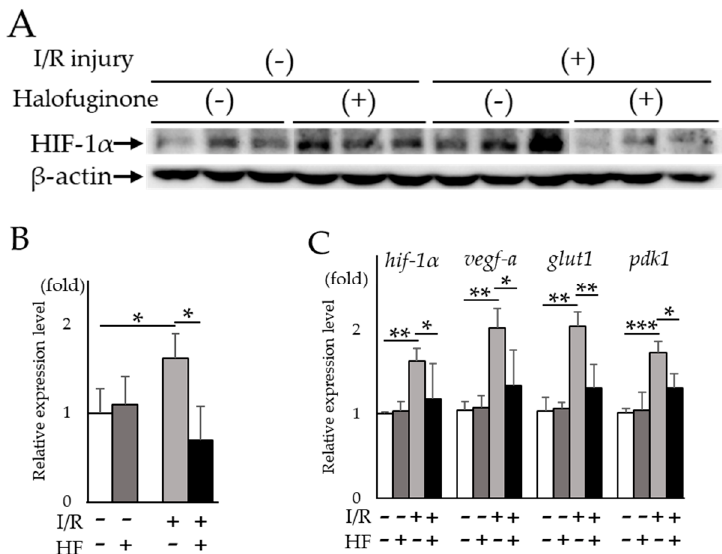
Figure 3. Suppression of increased HIF-1 α and upregulated target genes by halofuginone administration in I / R retinas. ( A ) Western blotting for HIF-1 α and β -actin in control or I / R retinas with or without halofuginone administration ( n = 3). ( B ) Quantification of the blots showed that halofuginone administration suppressed increased HIF-1 α protein expression. ( C ) Hif-1 α and its representative target genes detected by qPCR ( n = 3). Note that upregulated genes were suppressed by halofuginone administration. Gapdh was used as the internal control. Error bars indicate the standard deviation. HF; halofuginone. * p < 0.05, ** p < 0.01, *** p < 0.001, Student’s t -test.